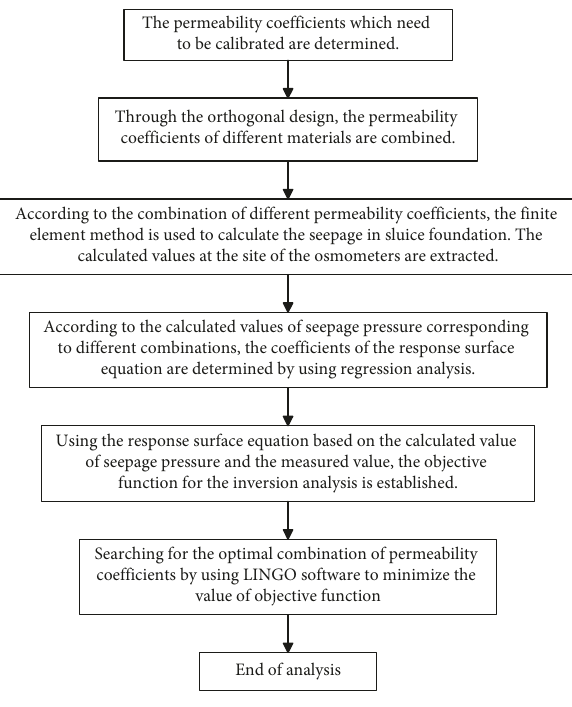
Figure 16: Flowchart for calibration of permeability coefficients. Table 1: Design value and calibrated value of permeability